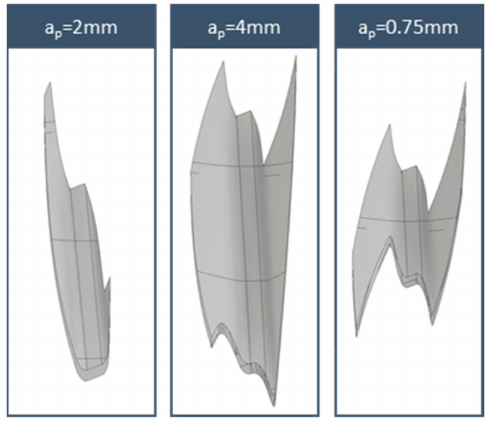
Figure 14. Solid chip geometries for strategy 4.